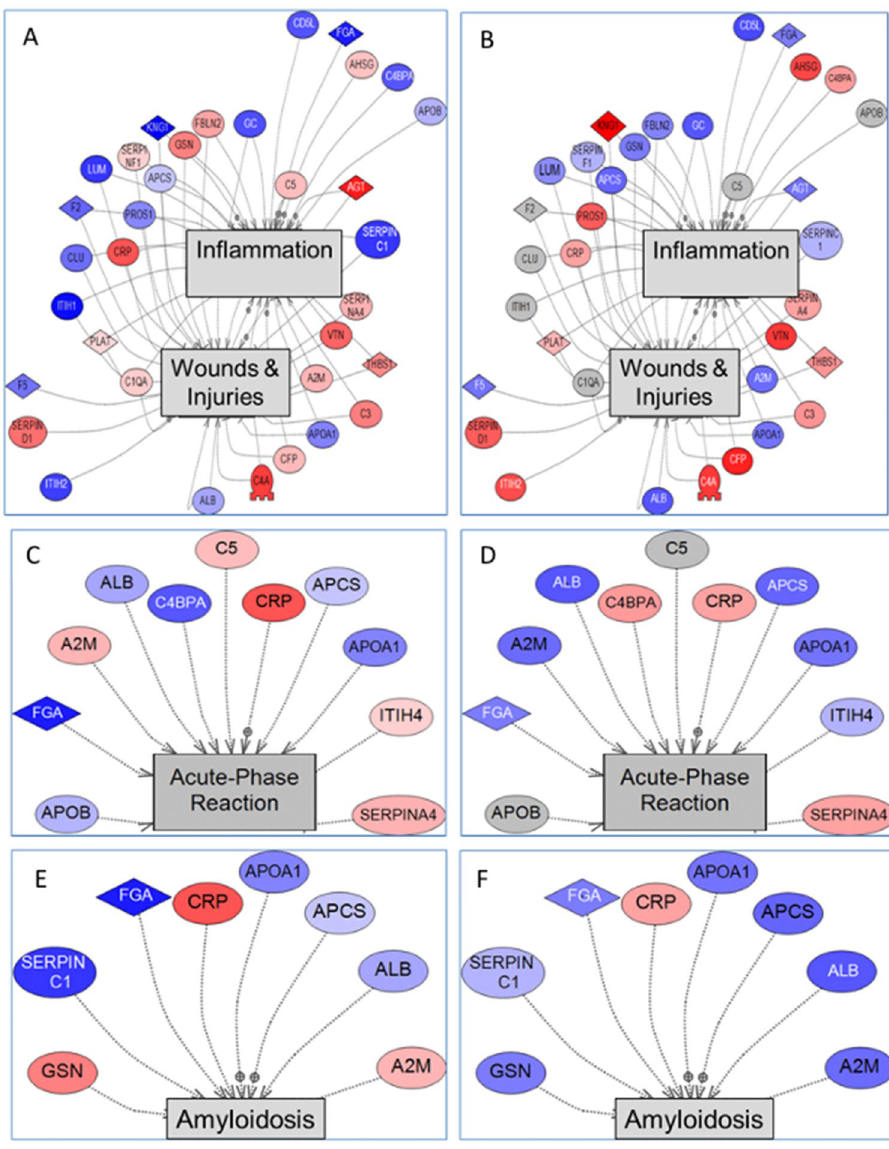
Figure 3. Pathway Studio images of subnetwork enrichment analysis (SNEA) of (A,B) the combination of inflammation and wounds and injuries, (C,D) acute phase reaction pathway and (E,F) amyloidosis pathway. The proteins that were identified by iTRAQ for the two groups (red tide and IRL) were compared to the Crystal River control group by Pathway Studio using subnetwork enrichment analysis. (A,C,E) Pathways built with differentially regulated proteins from serum of manatees exposed to red tide; (B,D,F) Overlay of differentially regulated proteins from serum of manatees collected from the IRL on the same pathways. Red, increased protein amount; blue, decreased protein amount, and gray, protein is not